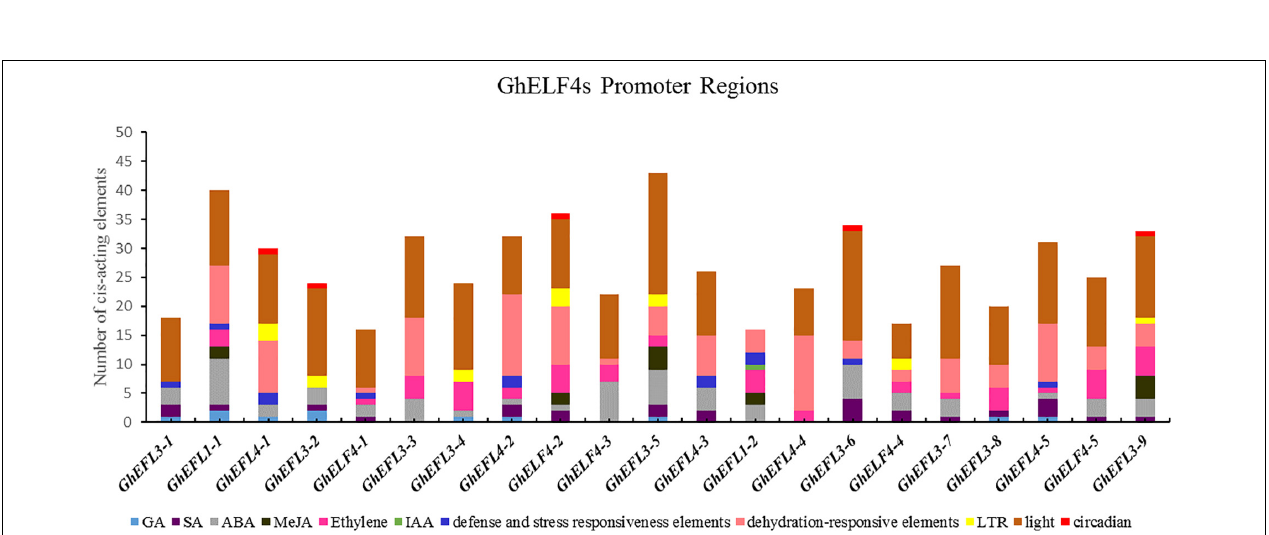
FIGURE 5 | The cis -acting elements of stress-related and plant hormone response in the GhELF4 genes promoter regions. The proportion of each type of related cis -acting elements in 21 GhELF4 genes.